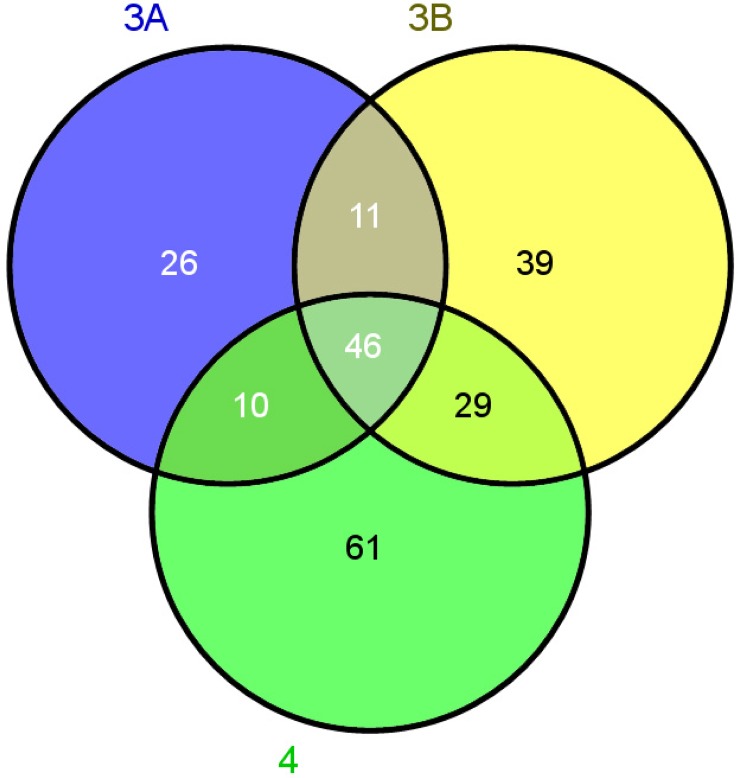
Venn diagram indicating the differentially co-expressed proteins (DCPs) from the patients with the three stages of Coats' disease.The numbers in parentheses indicate the total number of DCPs in stage 3A, stage 3B and stage 4, which are represented by purple, yellow and green, respectively.